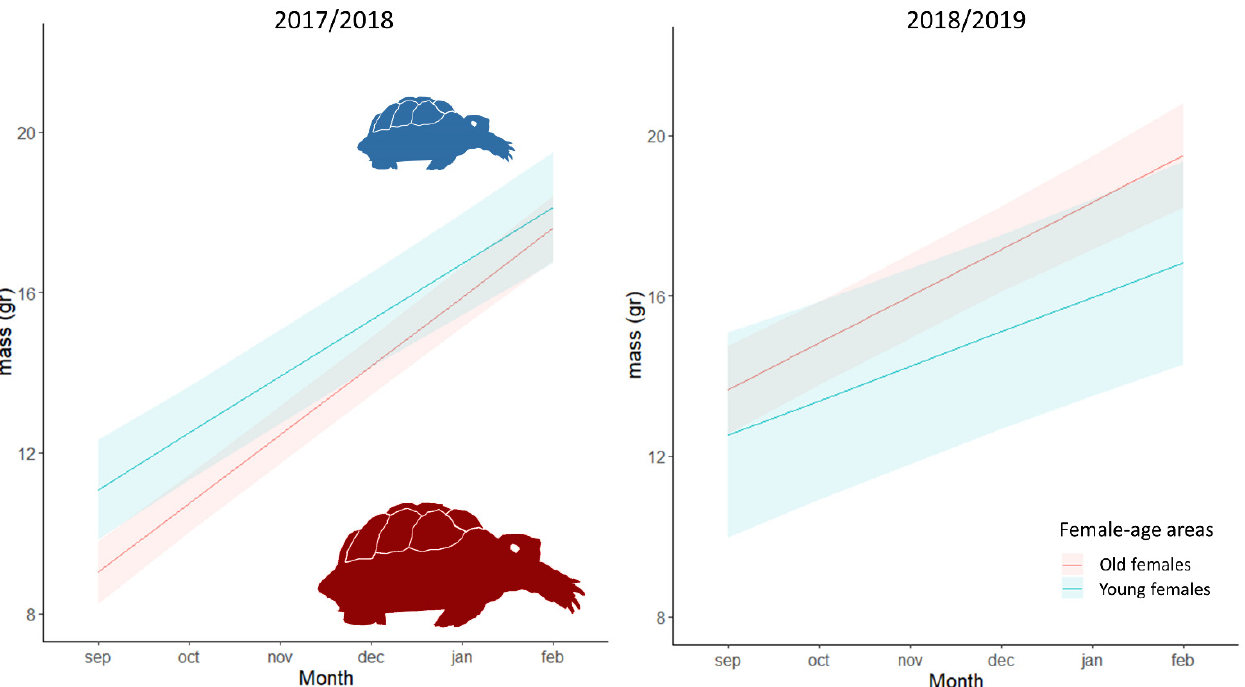
Figure 3. Relationship between hatchling body mass (in g) and months, of young females (in blue) and old females (in red) during the study period. Body mass was calculated with the linear mixed model that best fit the observed data, which include the interaction between month, female age and period and the random effect of the individual (Table 2). Lines represent the estimated mean values, and the shadow areas correspond to the confidence interval (95%).